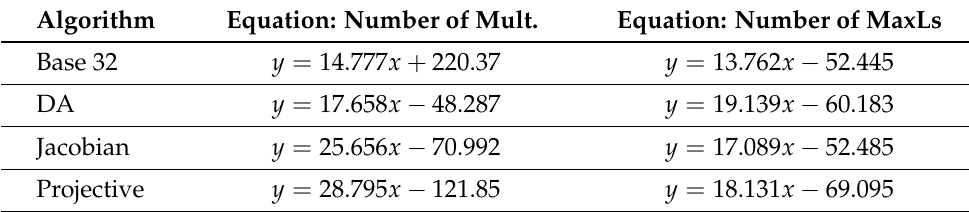
Table 5. List of Algorithms’ Linear